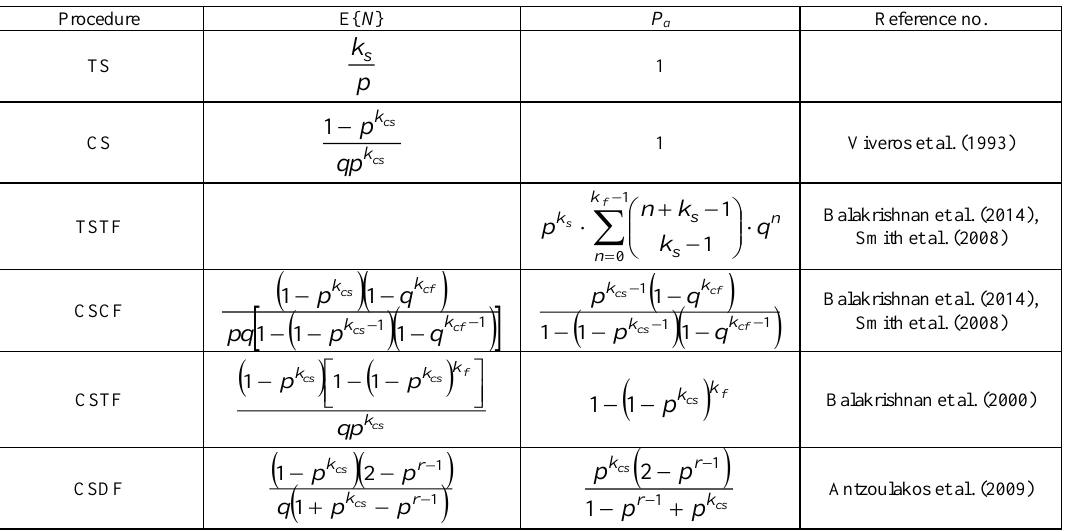
Table 1. E { N } and P a for various